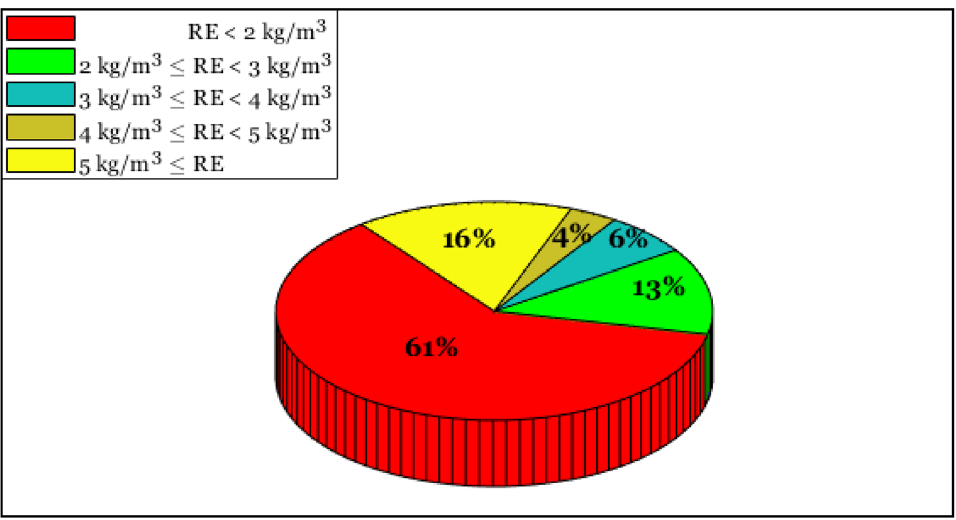
Figure 5. The cumulative frequency of the residual error (RE) of the LSSVR for estimating the DES’s